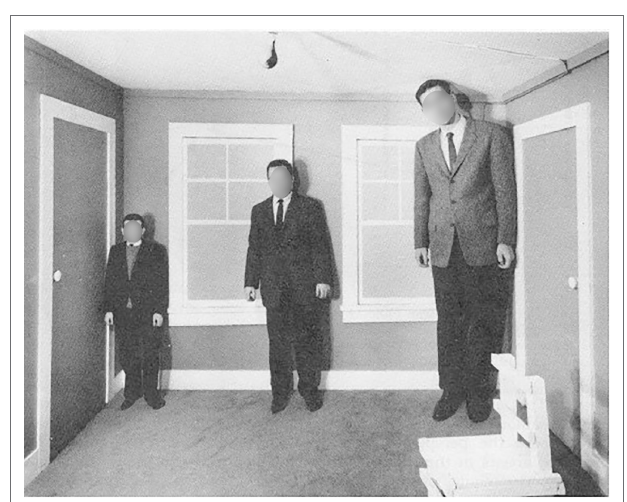
FIGURE 5 | Photograph of an Ames’ room size illusion. The viewing distance of the right corner is closer than the viewing distance of the left corner, but from a particular perspective the correspondingly tilted edges between floor and background wall and between ceiling and background wall appear parallel so that about equally sized men located alongside the background wall from the left to the right corner seem to vary in size. Retrieved from http://www.anopticalillusion. com/2012/07/vintage-ames-room-illusion/. Reproduced with